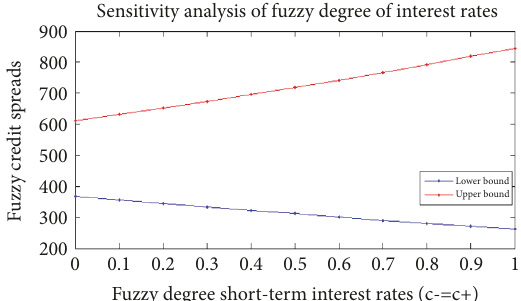
Figure 7: The dynamics between fuzzy credit spreads and counter- party